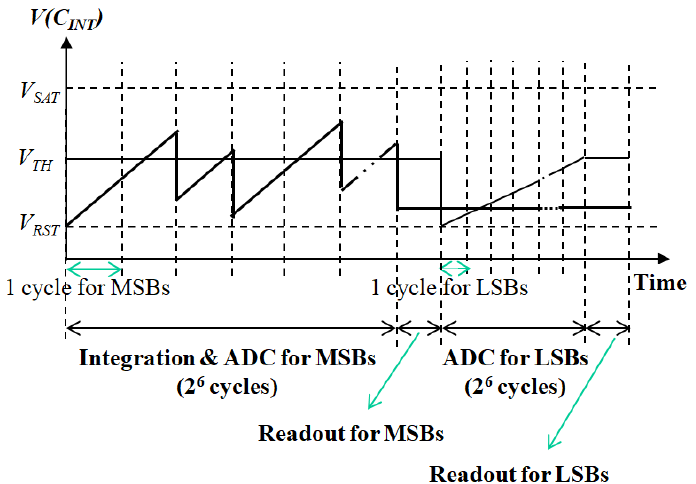
Figure 1. Basic concepts of the proposed pixel-level analog-to-digital converter (ADC).